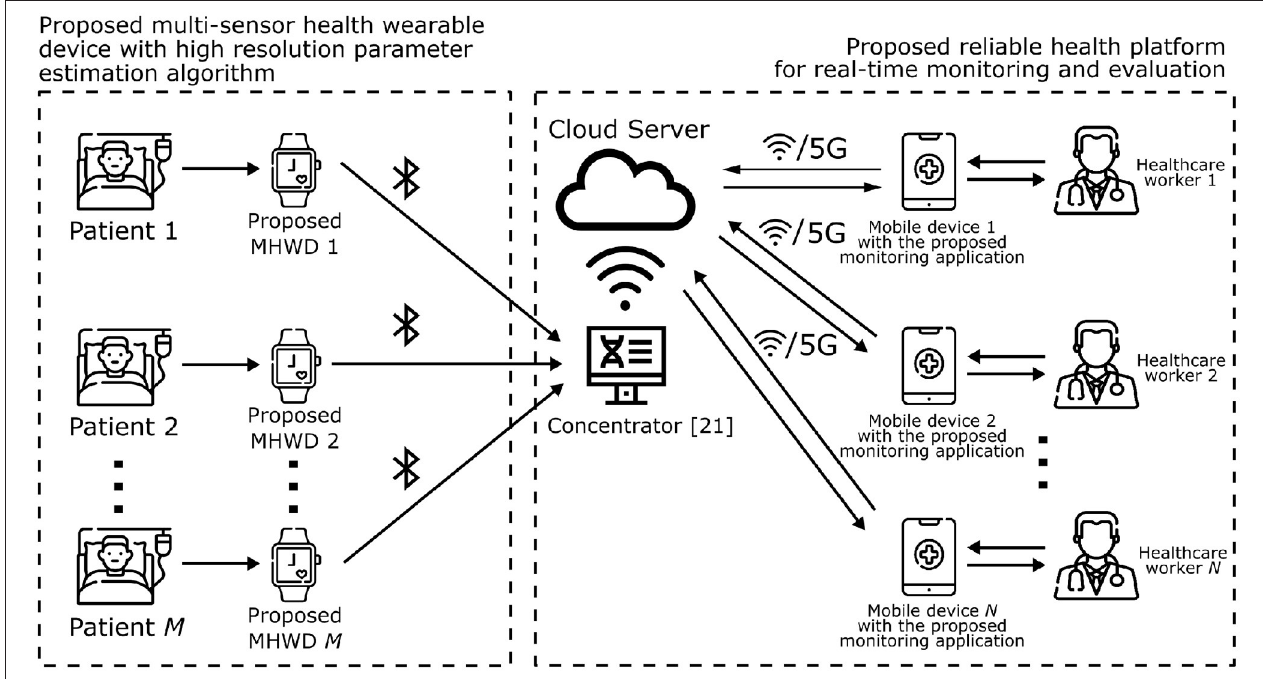
FIGURE 1 | Diagram of the proposed healthcare framework, consisting of a multi-sensor health wearable device, PPG high resolution parameter estimation, and real-time monitoring application.